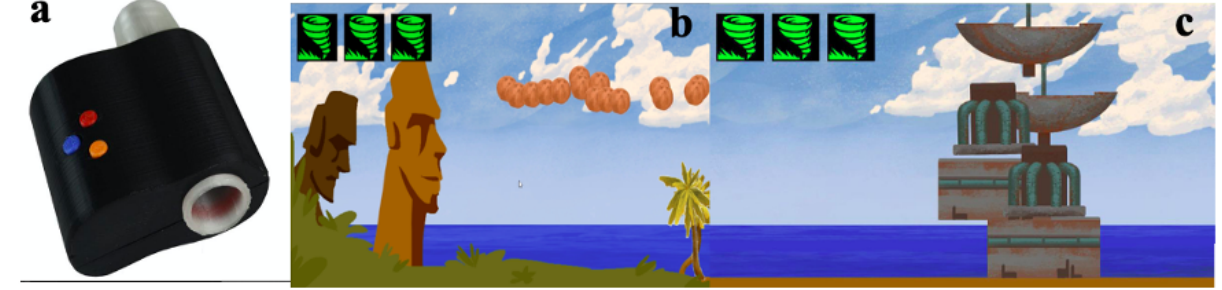
Figure 1. Representation of the game controller and the TikiFlow game. Children forcefully exhale in the mouthpiece of the game controller (a) to propel plant seeds, water them, and repopulate Tiki island with up to 5 attempts in the Tikiflow tablet-based game (b,c). The peak expiratory flow results appear at the end of the game. Images are copyrighted to